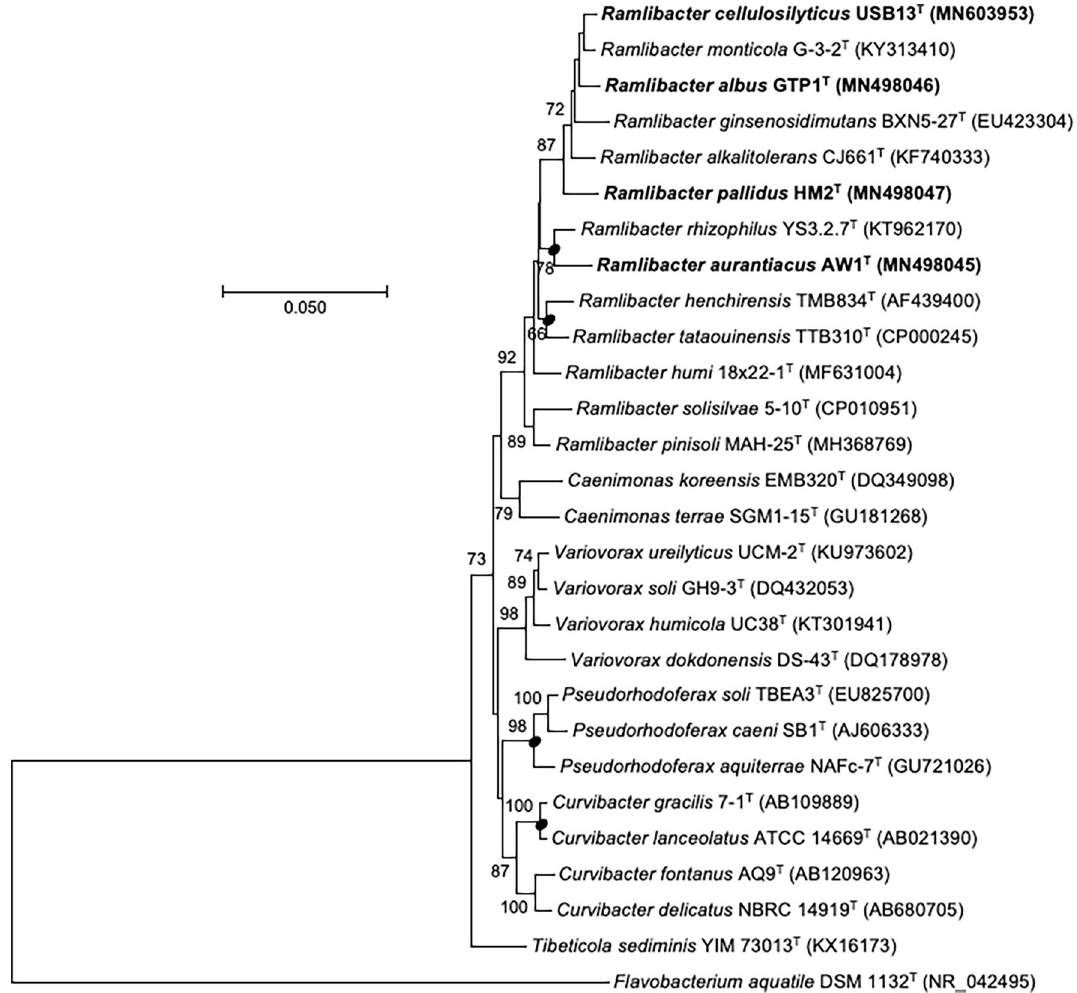
Figure 1. Maximum-parsimony (MP) tree reconstructed based on 16S rRNA gene sequences, showing the relationship between strains USB13 T , AW1 T , GTP1 T , and HM2 T and other closely related type strains. Bootstrap values based on 1000 replications are listed as percentages at branching points. Only bootstrap values exceeding 50% are shown. Bar, 50 substitutions per nucleotide